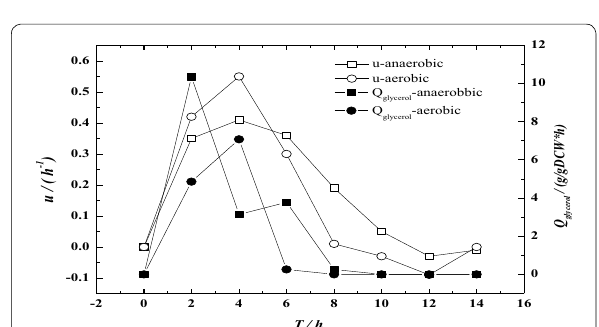
Fig. 8 The relationship with μ and Q glycerol observed in EB-06 biohydrogen production under aerobic and anaerobic